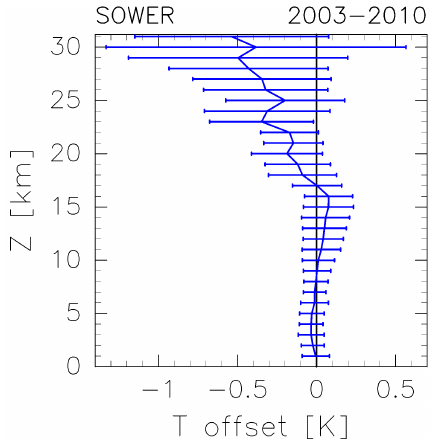
Figure 4. Temperature bias caused by the RS80 pressure bias via the altitude error estimated for all soundings listed in Table 1. Hor- izontal bars indicate one standard